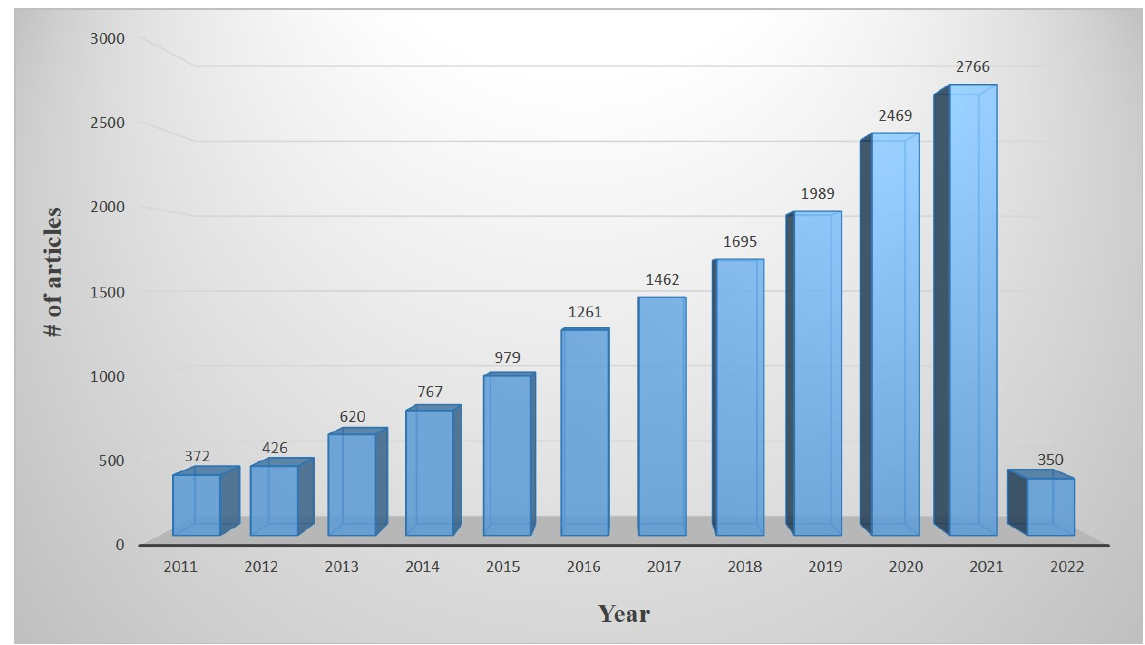
Figure 1. Annual article frequency as indicated by the Scopus database at date 12 January 2022 (Searched with a keyword ‘methylene blue dye degradation’).